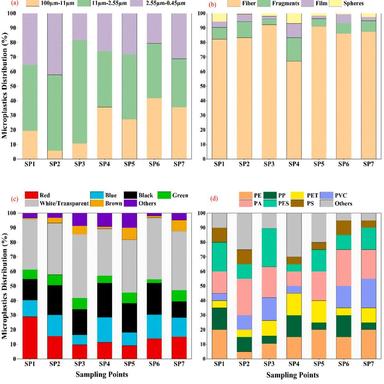
Distribution of MPs based on (a) size, (b) shape, (c) color, and (d) polymer types in GW at different sampling points (SP).